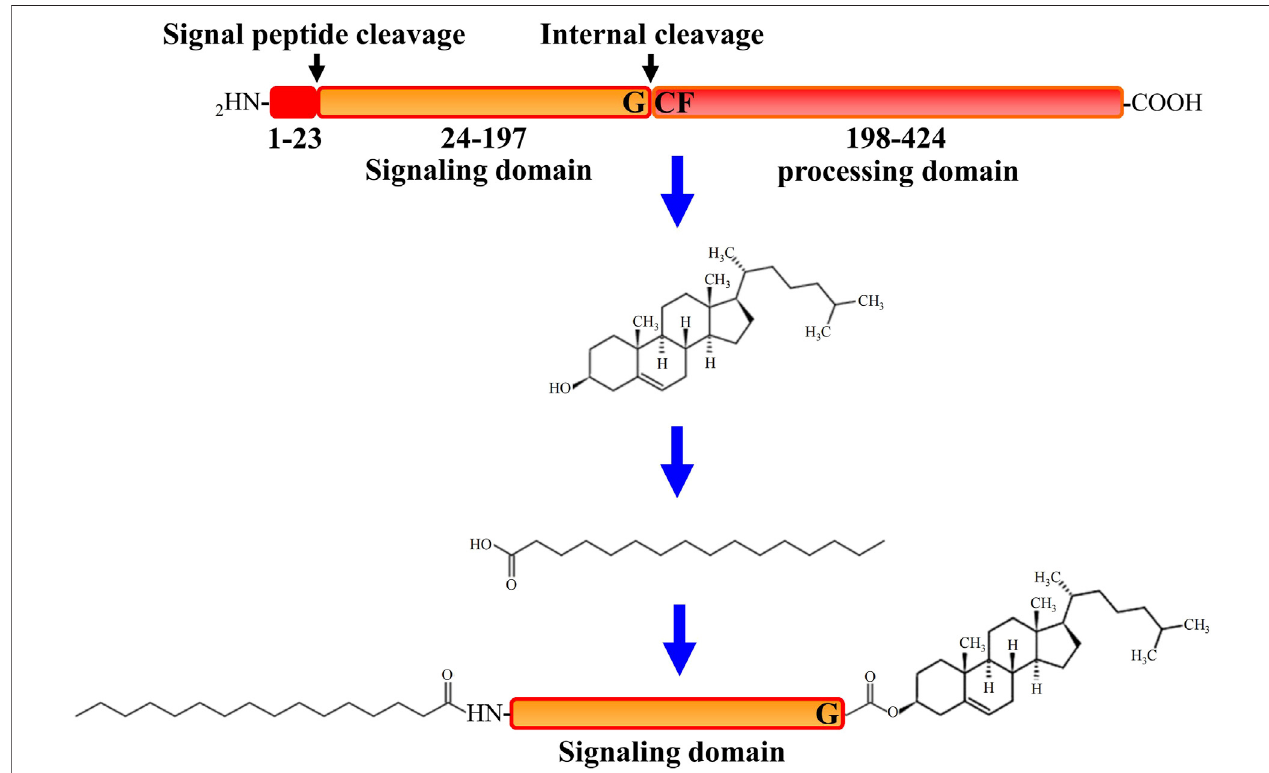
FIGURE1| AschematicdescriptionofprogressofHedgehogproteinmaturation.Inthe fi rststepofprocessingafterHedgehog(HH)proteintranslation,C-terminal initiates the catalytic action through its processing domain and leads to form an internal thioester between a cysteine and a glycine residue at the cleavage site. The C-terminaldomainisthenreleasedbynucleophilicattackbythehydroxylgroupofcholesterol,resultinginthecovalentattachmentofcholesteroltotheCterminusofthe N-terminal domain. Further more, the N terminus of the N-terminal domain is palmitoylated by the acyltransferase Skinny after signal peptide cleavage.